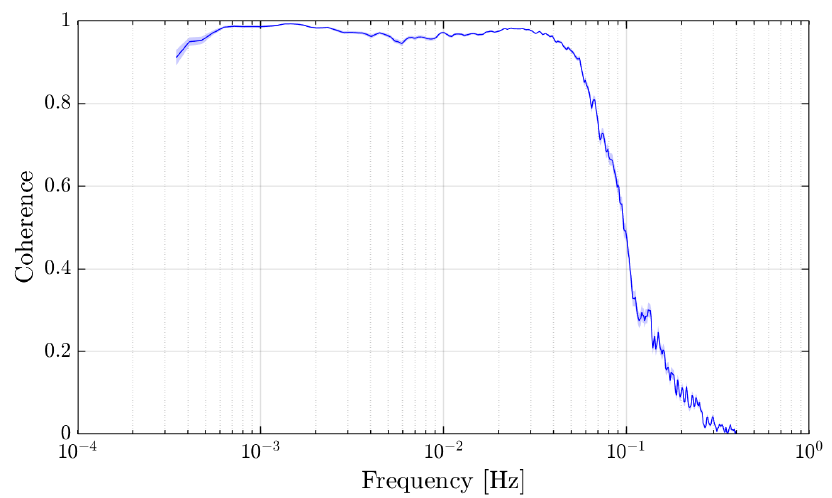
Figure 10. The magnitude of the coherence between our vacuum chamber temperature and our resonator’s acceleration data. The coherence is greater than 0.8 between 0.3mHz and 60mHz, indicating that temperature is a significant noise source. The coherence function is not plotted below 300µHz because the low number of averages causes large uncertainties. The shaded area represents the estimated error bars of the